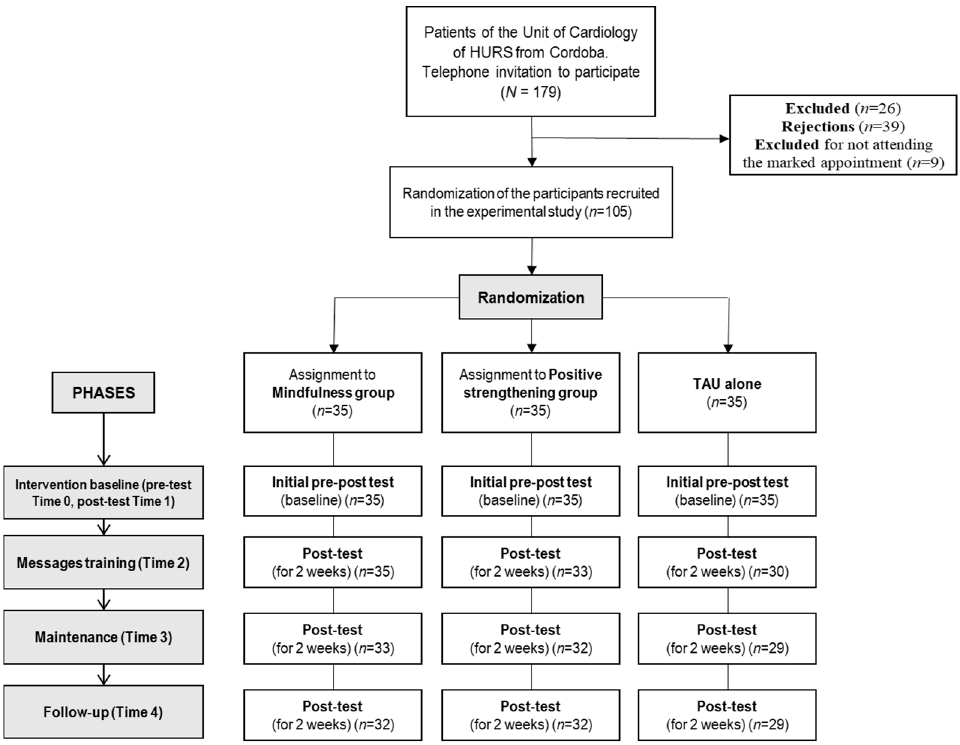
Figure 1. CONSORT (Consolidated Standards of Reporting Trials) diagram. Recruitment and study performance. HURS = Reina Sofía University Hospital.